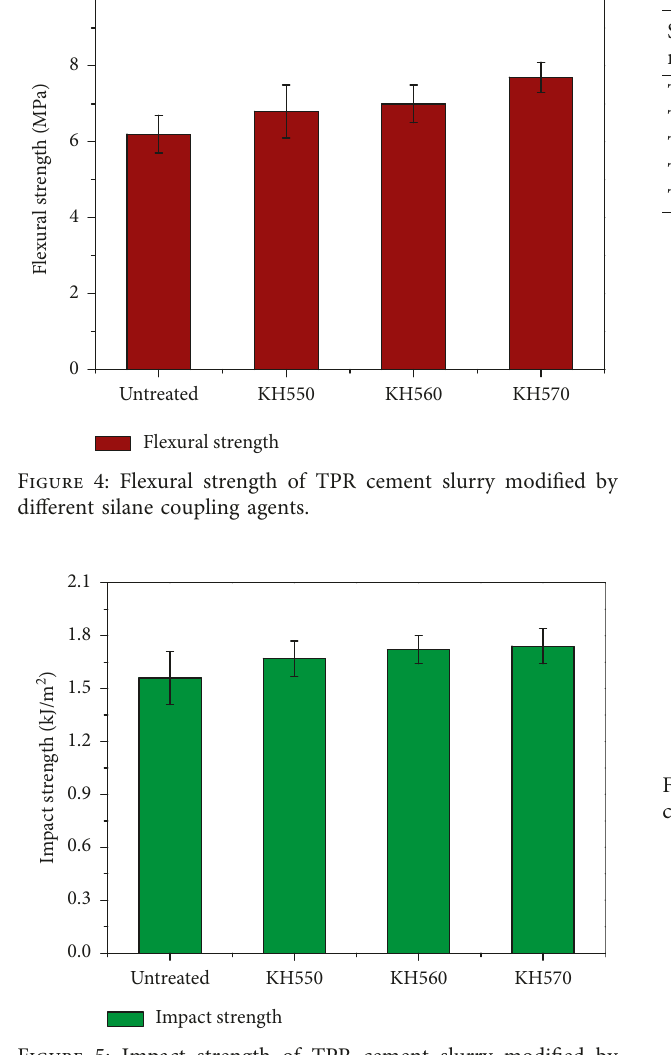
Table 2: Rheology and free liquid of modified TPR cement slurry.